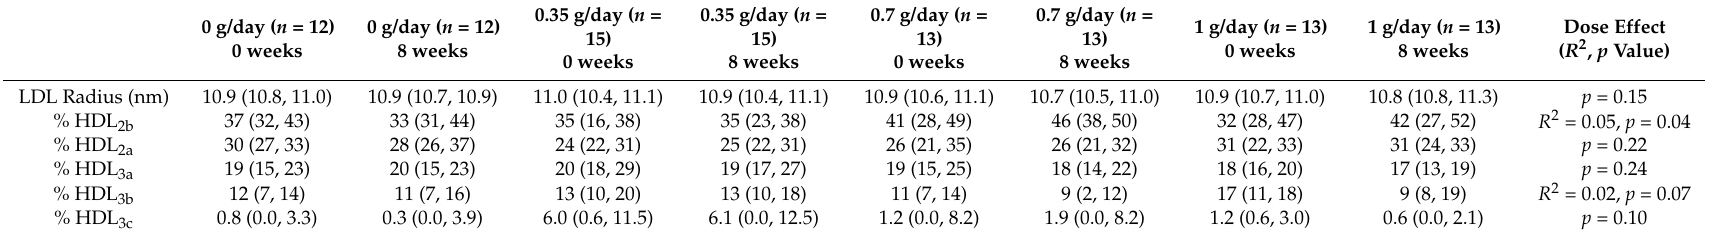
Table 5. Lipoprotein particle size following supplementation with 0–1 g/day n -3 LCPUFA from HiDHA™ tuna oil (values median (25th percentile, 75th percentile); n = 29).